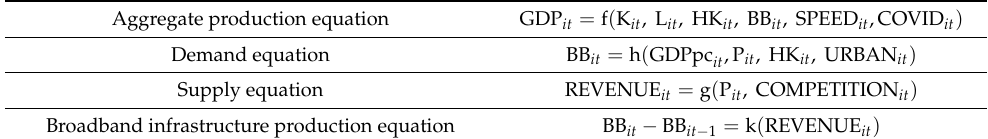
Table 1. The system of equations for the structural